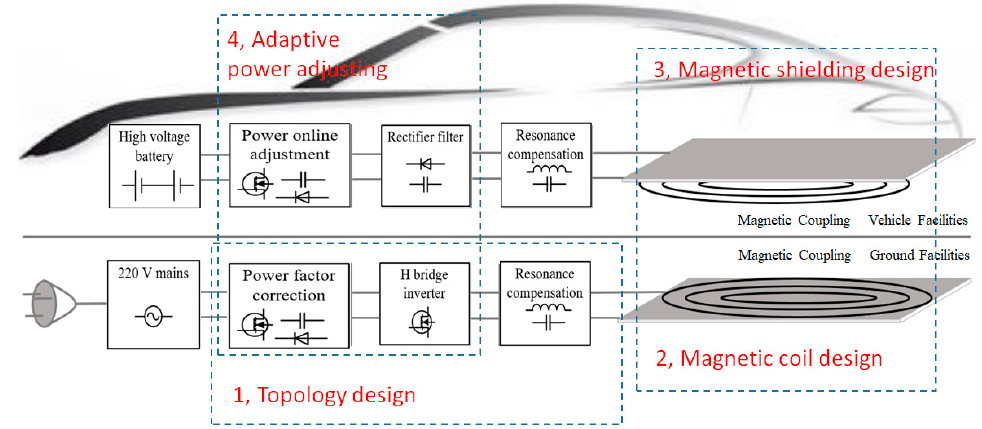
Figure 1. Overall schematic of the wireless power transfer (WPT) system.